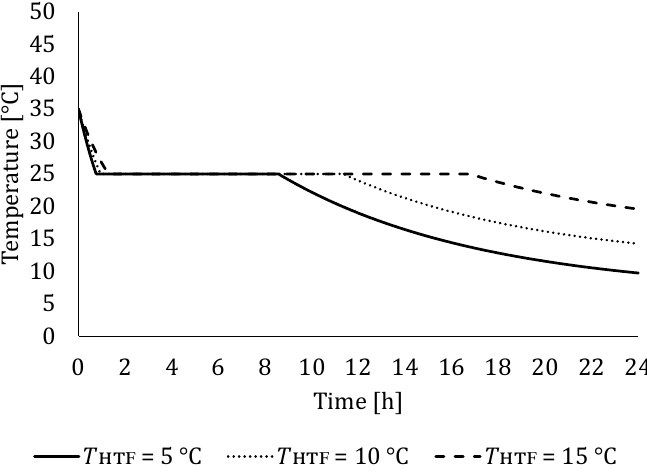
Figure 16. Comparison of transient variations of PCM temperatures during solidification obtained numerically for different HTF inlet temperatures, HTF inlet flow rate 800 l/h and initial PCM temperature 35 °C.